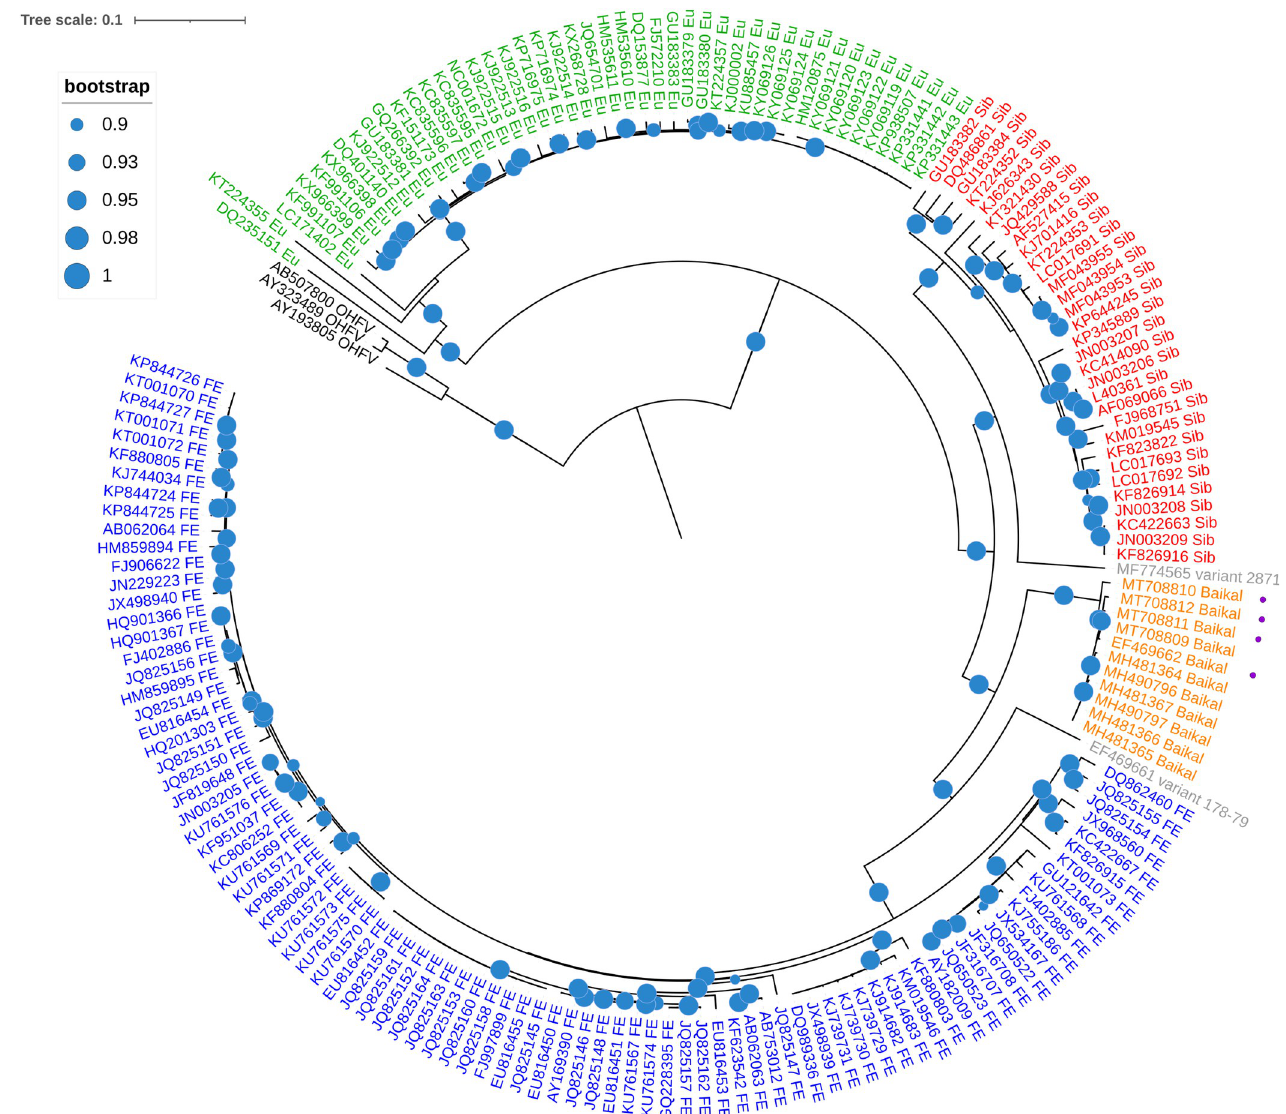
Fig 1. Reconstructed maximum likelihood whole-genome phylogeny for TBEV variants with 200 bootstrap replicates. Blue circles indicate bootstrap support of corresponding branches. Leaves are colored by group: red, Siberian subtype of TBEV (Sib); blue, Far-Eastern subtype of TBEV (FE); green, European subtype of TBEV (EU); black, Omsk hemorrhagic fever virus (OHFV) used as the outgroup species; orange, Baikal subtype of TBEV; gray, TBEV variants 2871 and 178–79 excluded from the GS analysis. Newly sequenced Baikal TBEV variants are marked with purple dots.